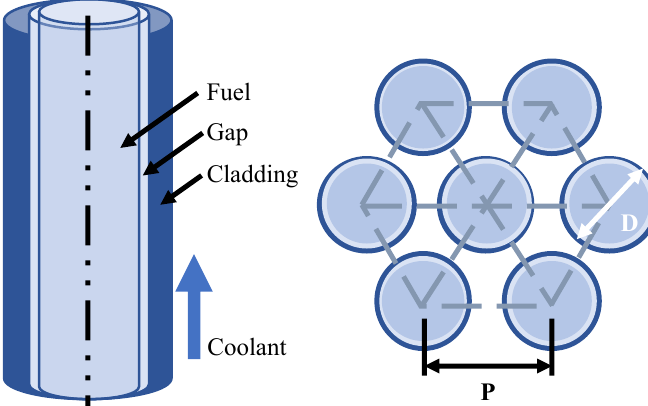
Figure 1. Pin and lattice geometries. Left: axial geometry of the pin-coolant system. Right: lattice geometry. Each triangle is a unit cell in the heat transfer model for a hexagonal lattice, representing half a pin and corresponding quantity of